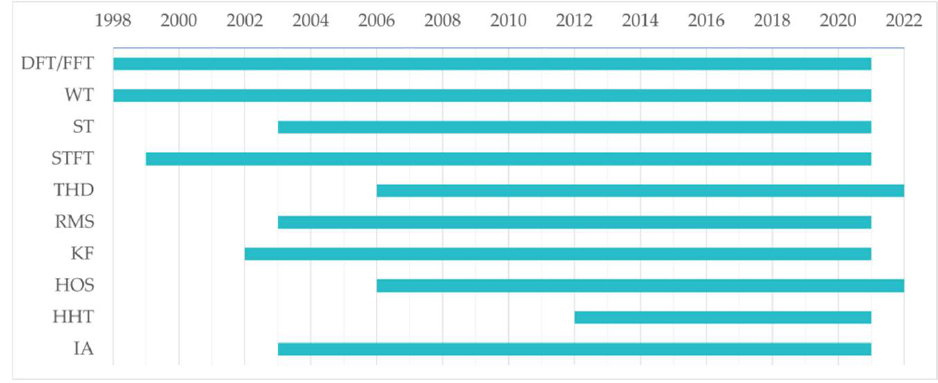
Figure 8. Time range in which the different power quality techniques have been